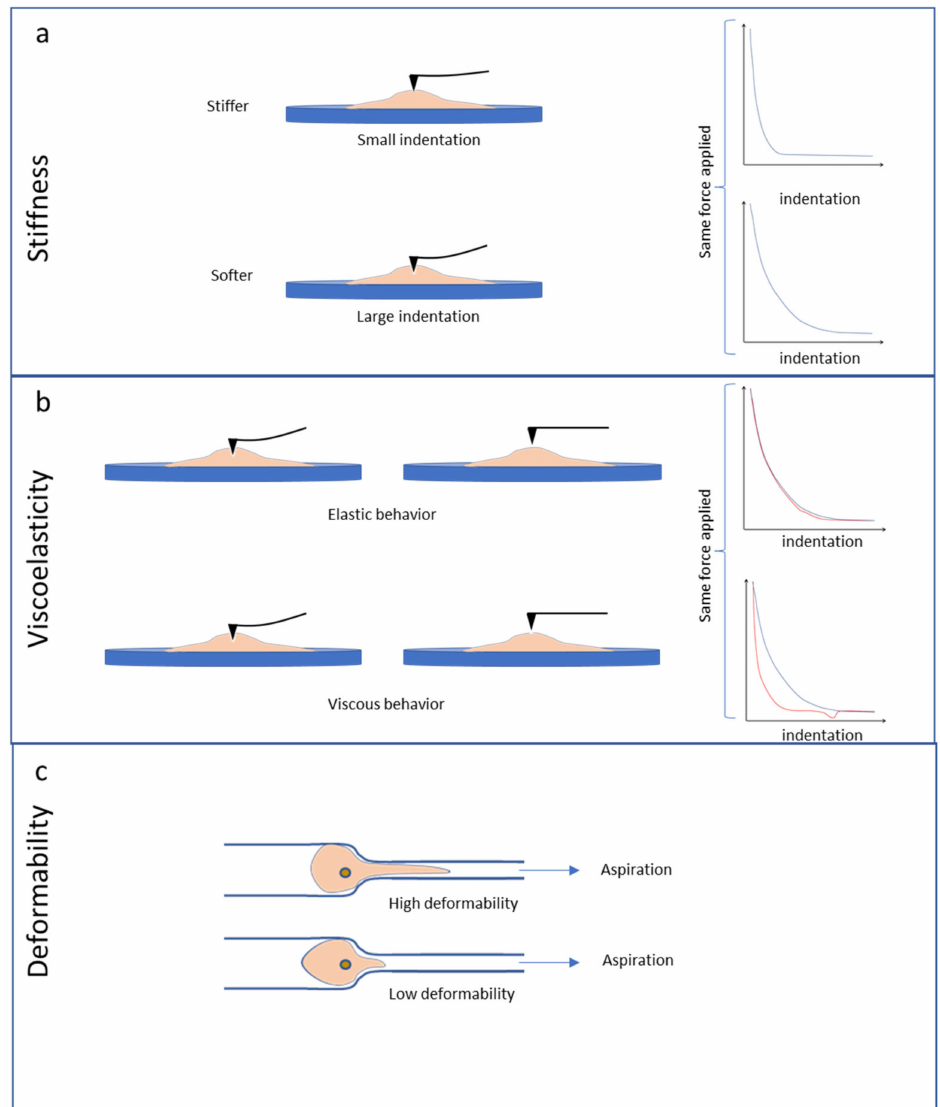
Figure 2. Schematic representation of cell stiffness, viscoelasticity and deformability properties. ( a ) For a given applied force, a larger indentation is observed for the softer cell. ( b ) A cell quickly recovers its original shape after indentation with small hysteresis for a more pronounced elastic behavior. Larger hysteresis is observed for a more viscous behavior. ( c ) The capacity of the cell to penetrate a thin capillary allows its deformability to be